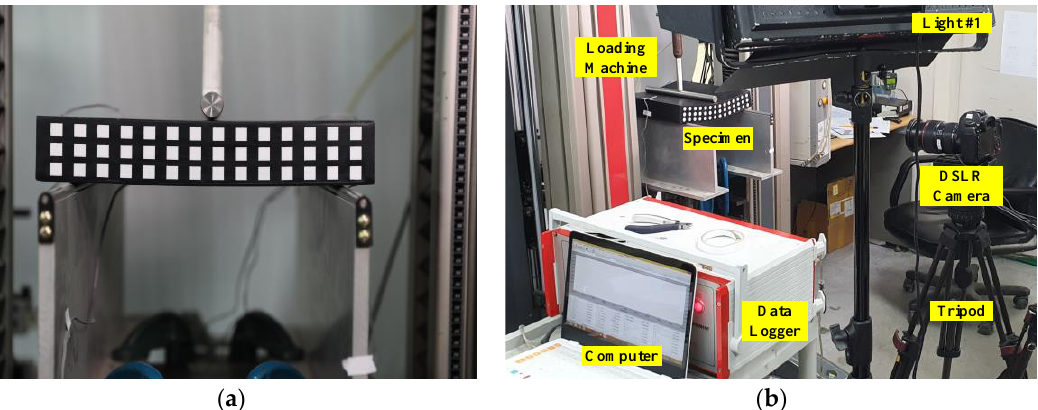
Figure 10. Experimental setup for the synthetic structural analysis. ( a ) Specimen used in the experiment, and ( b ) DIP experimental setting.